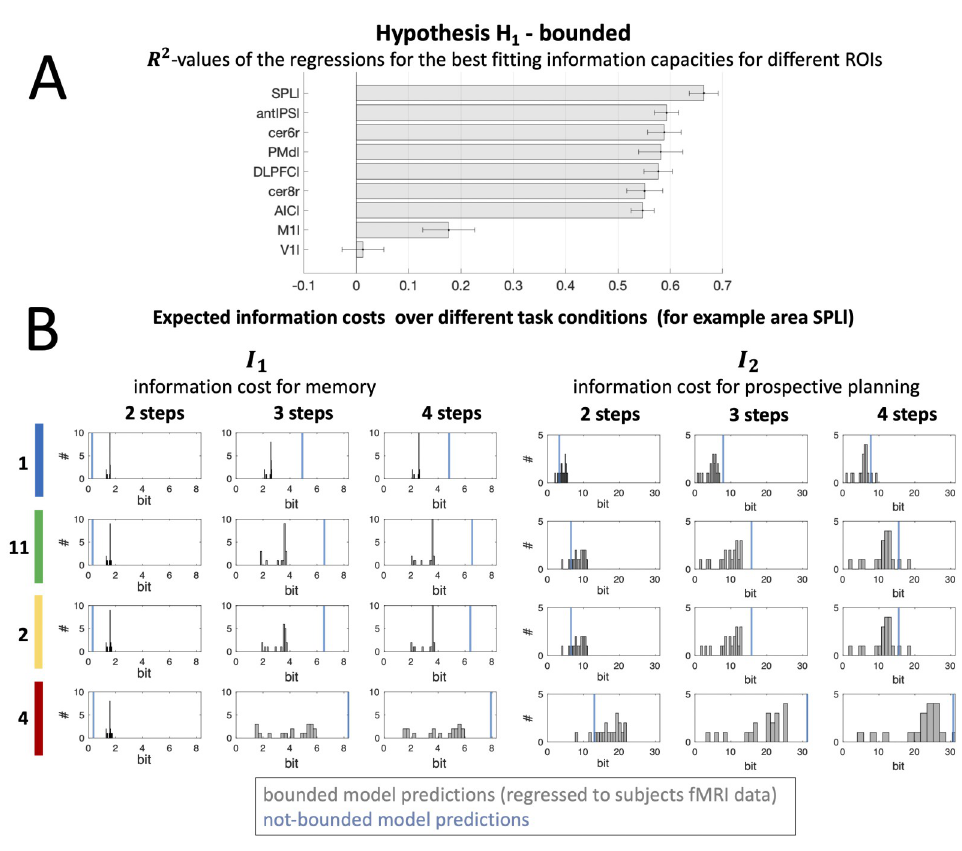
Fig 6. Bounded prospective planning (H 1 ) regression. (A) ROI comparison ranked by R 2 -values of the regressions for the best fitting information capacities for individual subjects for H 1 . Results are reported as the mean over R 2 -values for subjects’ individual best model fit for H 1 and normalized standard error (according to [31] to eliminate the between- subject variance, which does not contribute to the within-subject effect of the study). (B) Theoretical expected information costs I 1 (left) and I 2 (right) of prospective planning is based on model parameters determining memory and planning capacities fitted for all individual subjects (hypothesis H 1 “bounded”). Histograms represent the frequency distributions of the information costs, dependent on task conditions. Information values varied between bounded model predictions regressed to subjects fMRI data compared to the model predictions in the not-bounded case (in blue). Note that generally subjects lie below the information cost of the not-bounded decision-maker and only for the most simple 2-step conditions subjects’ information costs for memory ( I 1 ) deviate in the different direction from the predictions in the not-bounded case. This results from the specific task design and the fact, that bounds are provided on the total expected information. Decision-makers with not-bounded planning capacities can optimally assign resources to more difficult conditions and save memory costs for 2-step conditions, because no uncertainty about the target location will remain when s 2 is revealed given that all actions are planned prospectively under a high information resource for I 2